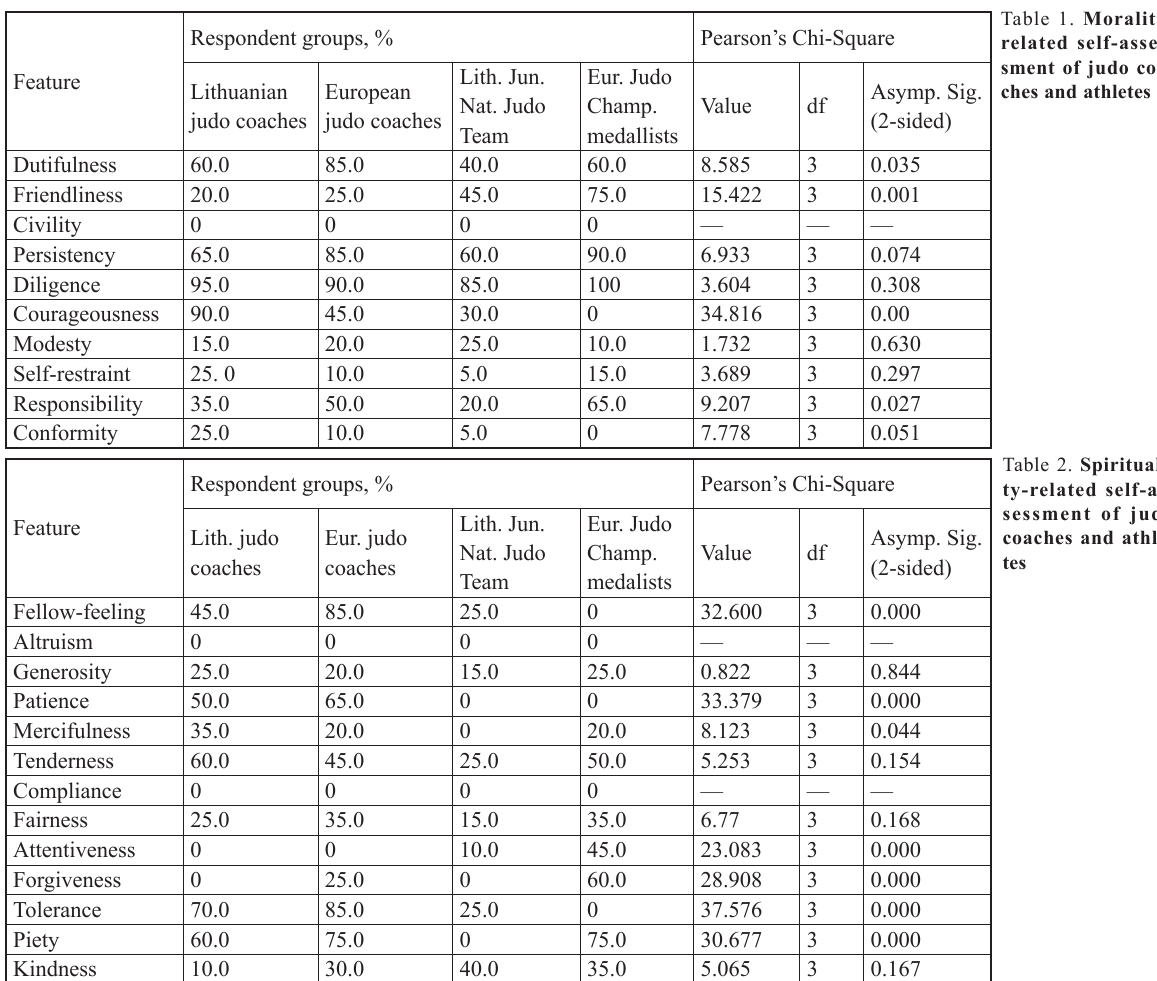
Table 1. Morality- related self-asses-